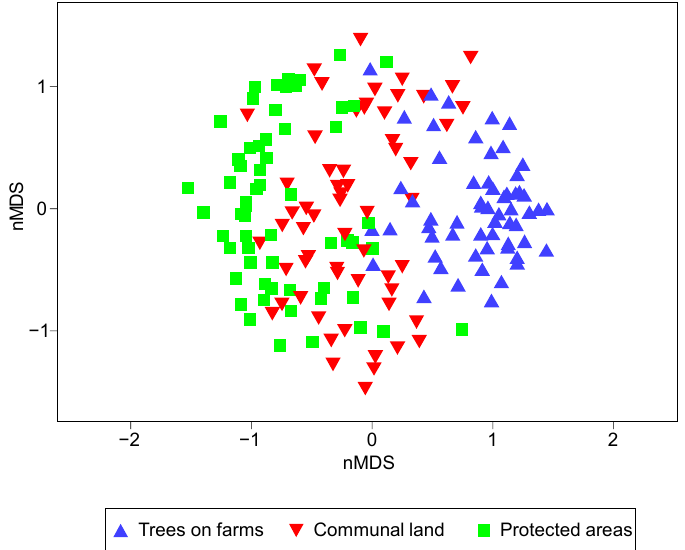
Figure 3. Species richness in the study areas; multi-dimensional scaling of the local assemblage of different land-uses.